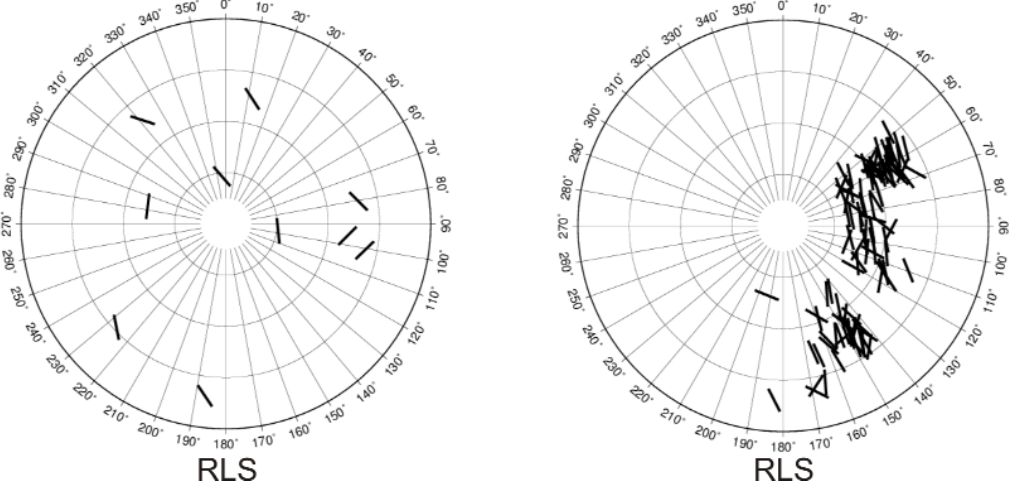
Figure 6. Equal area projections of the polarization directions measured at the RLS station for the periods before (left) and after (right) the Movri Mountain earthquake. The radius of the plots is scaled to an incidence angle of 40°.